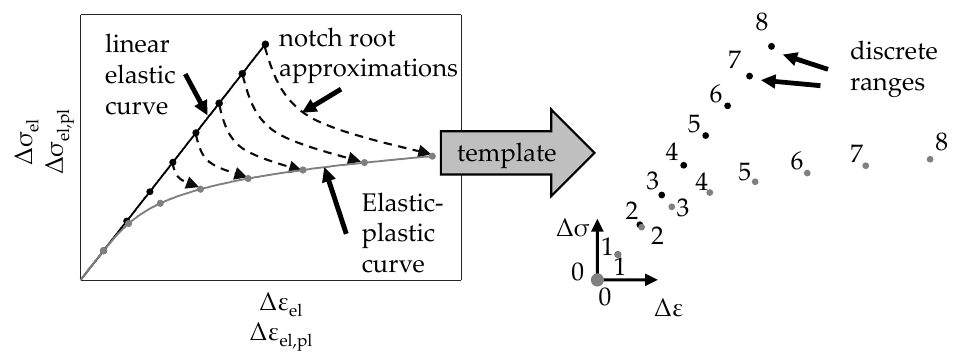
Figure 3. Creation of a discretized load-notch-strain-curve via notch root approximations [40]. The load-notch-strain curves of the component for the initial load and for the hysteresis branch are related. It is possible to derive the initial load-notch-strain curve from the load-notch-strain curve of the hysteresis branch. By halving the values of elastic stress Δσ , elastic-plastic stress Δσ , and elastic-plastic strain Δε range of every el el,pl el,pl second of the abovementioned interval of the load-notch-strain-curve of the hysteresis branch, the initial load-notch-strain-curve is obtained. This is used in Sections 4 and 5 to limit the investigation to the determination of the load-notch-strain-curve for the hysteresis branch.